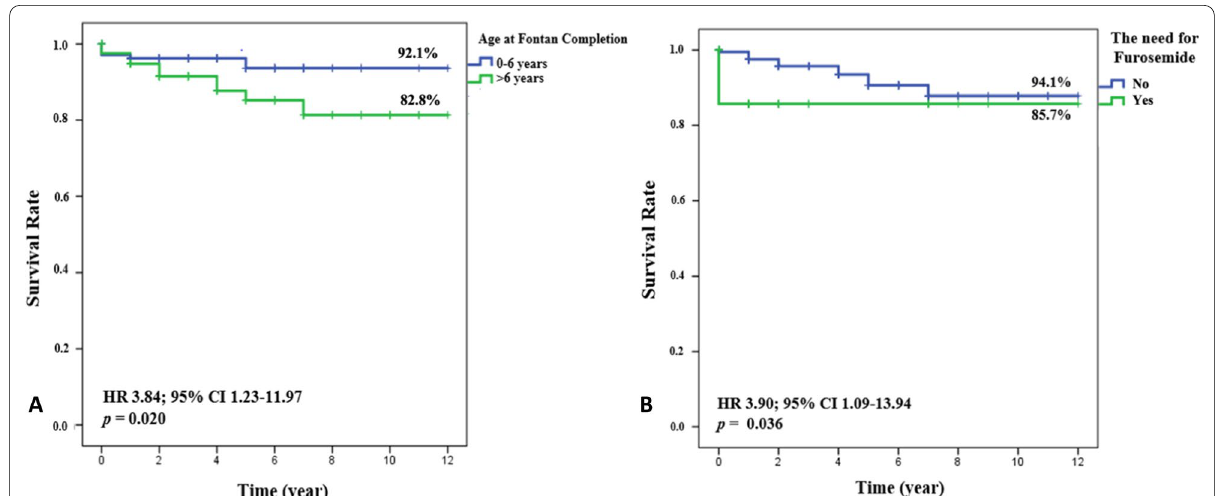
Fig. 2 A Kaplan–Meier survival curve based on age at Fontan completion and B based on the need for furosemide until the end of study period. HR: hazard ratio; CI: confidence interval. p < 0.05: statistically significant